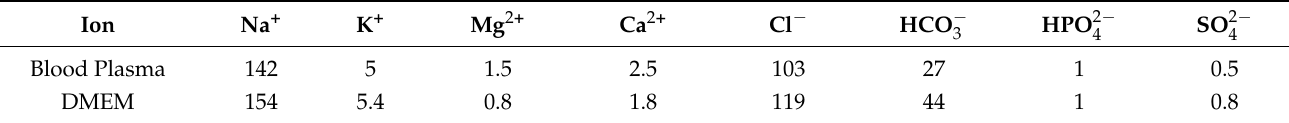
Table 3. Ionic concentrations in mmol/L.